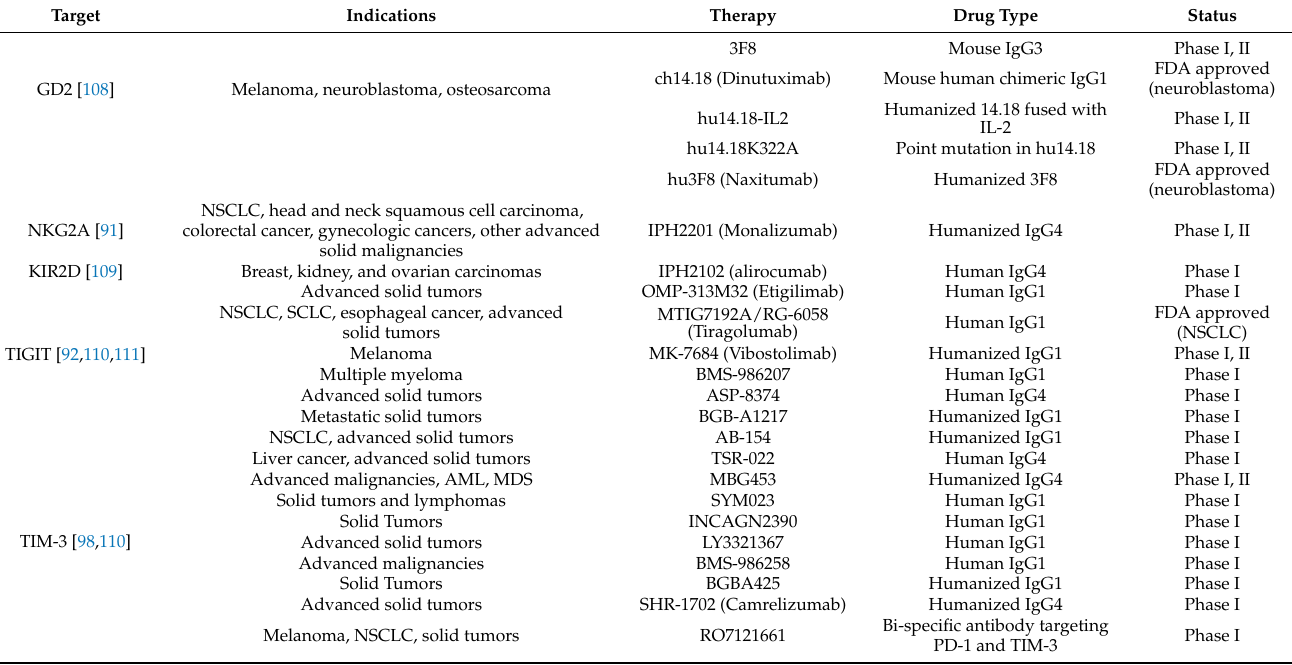
Table 1. Current antibody therapies that may enhance NK-mediated antitumor mechanisms.